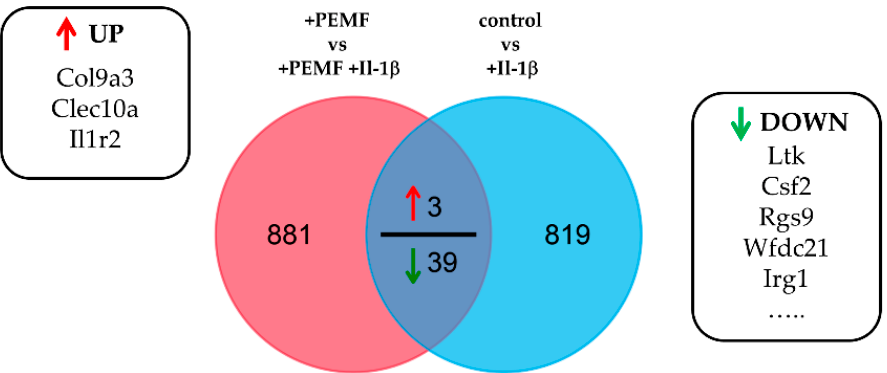
Figure 6. Quantitative VENN diagram showing overlap of genes derived from di ff erential expression analysis. Commonly regulated genes ( ≥ 2.0 fold change) are partially shown in the boxes. 3 of these genes were significantly up-regulated, whereas 39 genes were identified to be down-regulated (top 5 shown).